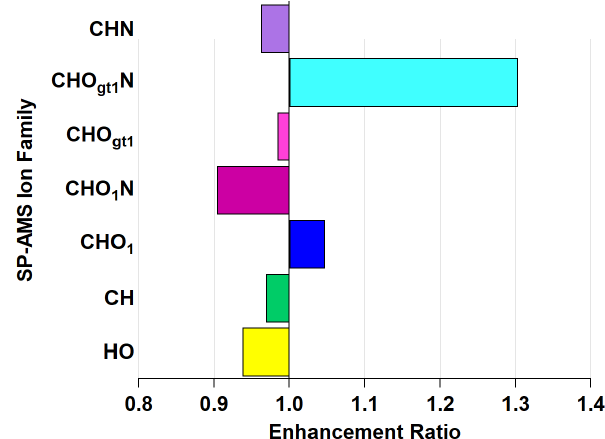
Figure 8. Enhancement and depletion of ion families measured (cid:113) by the AMS during OH oxidation. CHO 1 N is depleted, while CHO gt1 N is enhanced; however, both these families are present in low relative abundances, which may exaggerate the enhancement